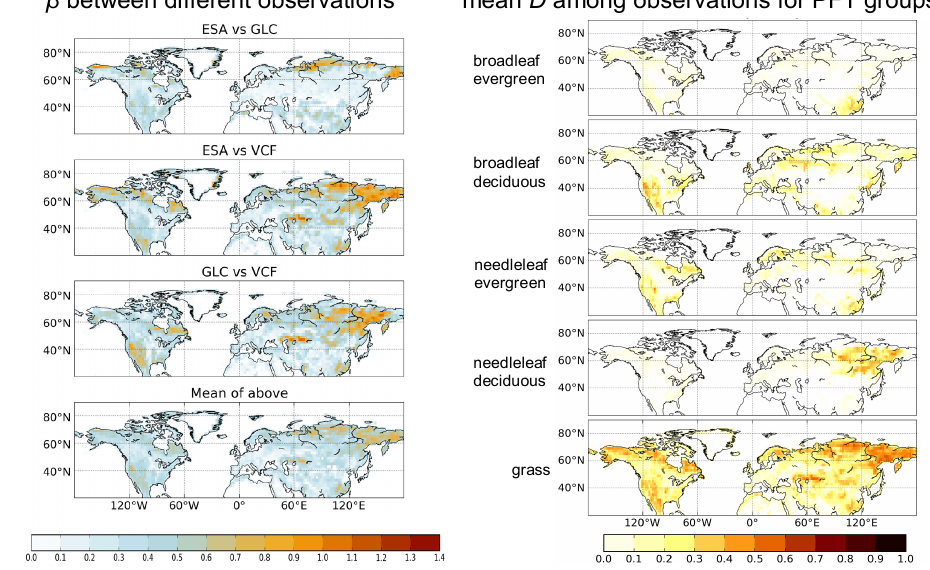
Figure 3. Beta diversity ( β) between the three observational data sets (ESA, GLC and VCF) (left panel), and mean dissimilarity index ( D) among them for different PFT groups (right panel). β ranges from 0 to 1.4, and D ranges from 0 to 1, both with higher values representing larger